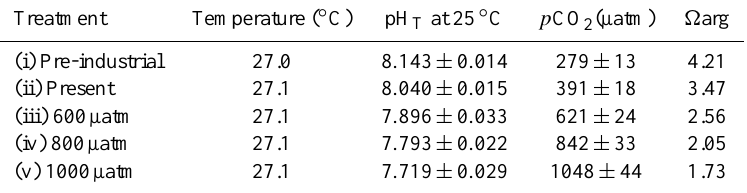
Table 1. Summary of mean physical and chemical conditions in each p CO 2 treatment of the primary polyp experiment. Standard deviation is shown for pH T and p CO 2 . The mean salinity and total alkalinity measured repeatedly during the experiments were 34.6 and 2257molkg − 1 , respectively. The value of (cid:127) arg was calculated using total alkalinity and p CO 2 . (i) pre-industrial p CO 2 , <300 µatm, (ii) present-day p CO 2 at 400µatm, and at two near-future conditions of (iii) 800µatm, and (iv) 1000µatm. All values are shown as mean ±standard